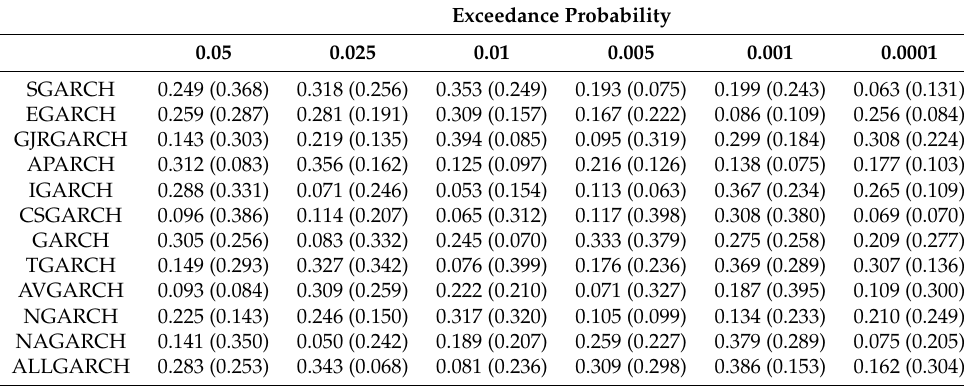
Table 8. p -values of the unconditional (conditional) coverage value at risk exceedance test for the log returns of the exchange rates of Ripple from 22 June 2014–17 May